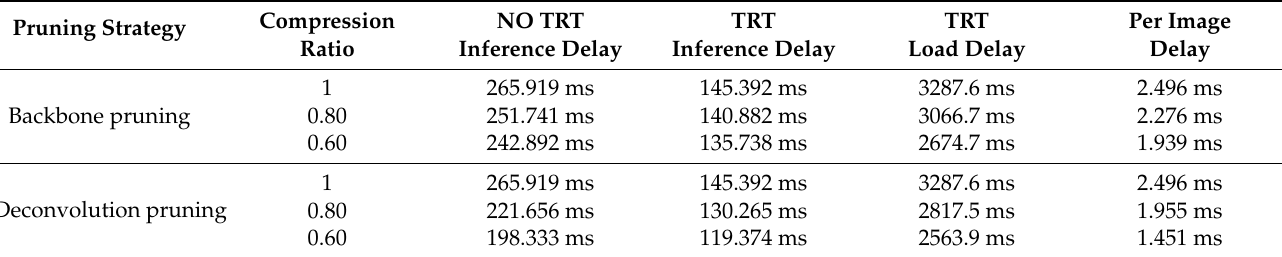
Table 4. Inference speed of different pruning strategies on the server.